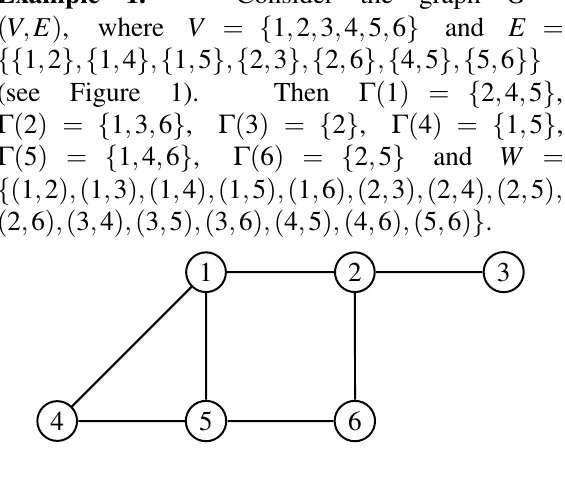
Fig. 1. Graphic representation of G = ( V , E